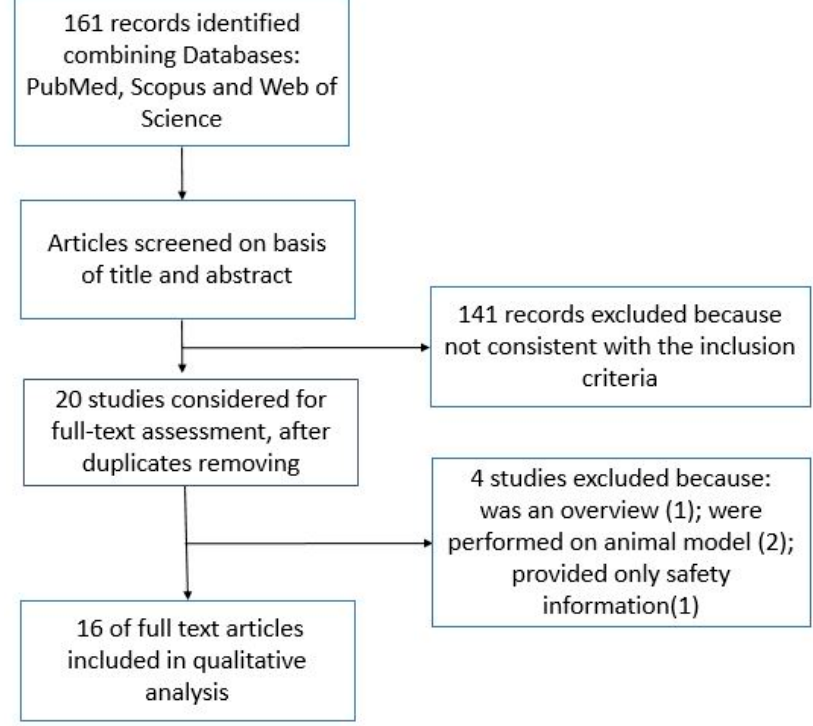
Figure 1. Flowchart of the selection process for the studies inclusion.